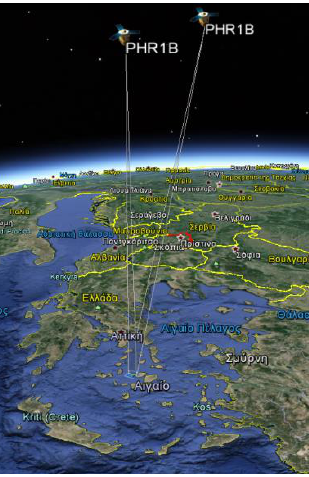
Figure 1. Stereo acquisition for 3D applications (Google Earth preview of the footprints and the satellite's position)